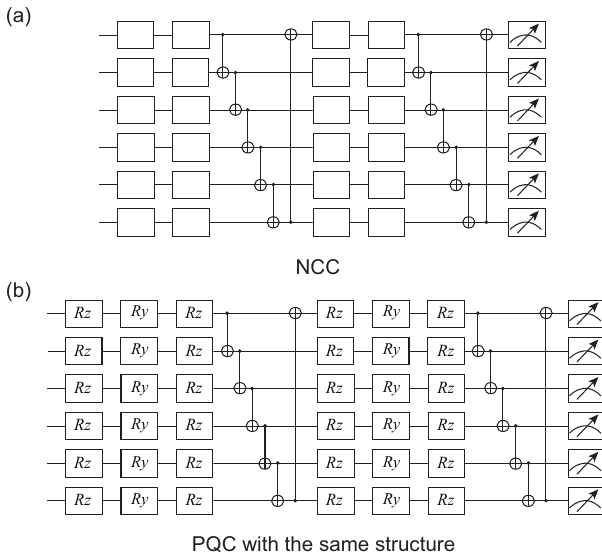
Figure 2. The ansatz in numerical simulation . ( a ) A cluster of NCCs, where each single-bit gate is selected with a certain probability from the following gates: H gate, S gate, I gate, and T gate. ( b ) PQC with the same structure as NCC in ( a